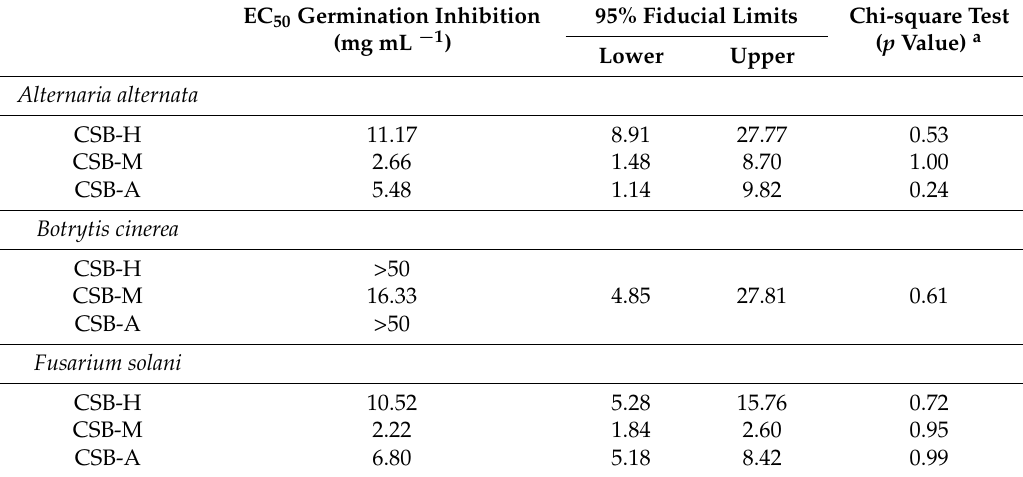
Table 4. EC 50 of CSB inhibiting Alternaria alternata , Botrytis cinerea and Fusarium solani spore germination. EC 50 Germination Inhibition 95% Fiducial Limits Chi-square Test ( p Value) a (mg mL − 1 ) Lower Upper Alternaria